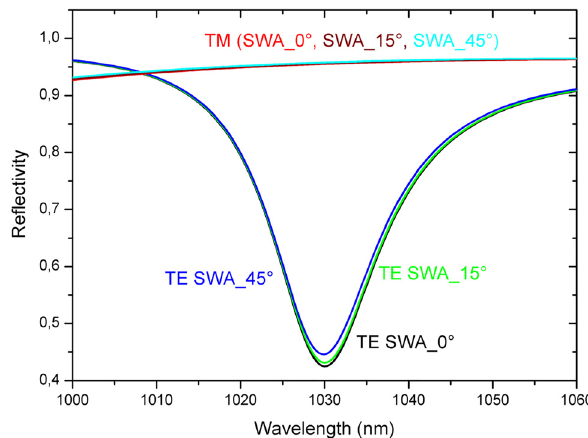
Figure 5: Calculated reflectivities for TE and TM polarized radiation for 3 different angles of the side walls (SWA) of the GWOC ’ s grating profiles.